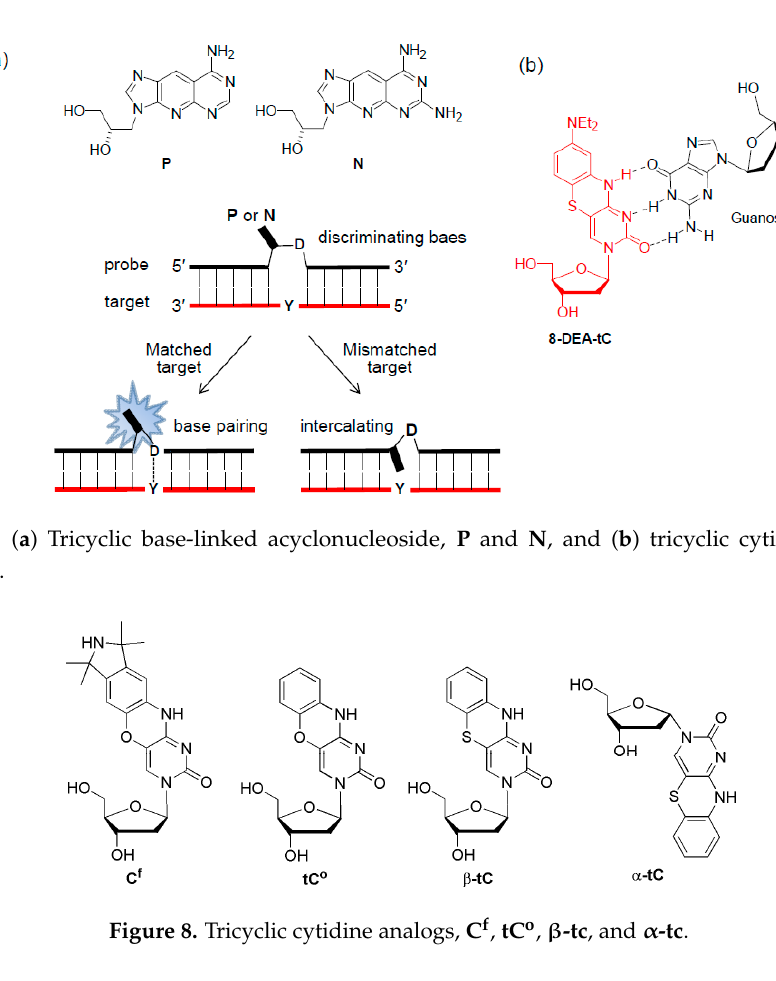
Figure 9. HyBeacon probe.